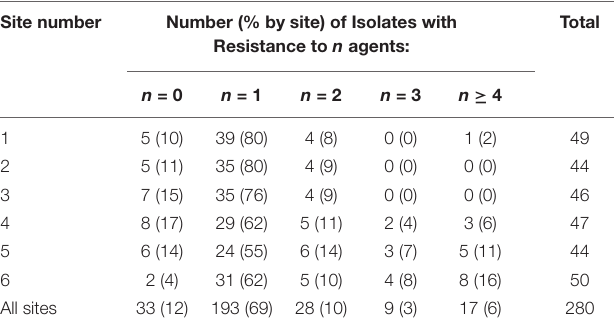
TABLE 2 | Percentage (%) of multi-drug resistant E. coli isolates by sampling site. Site